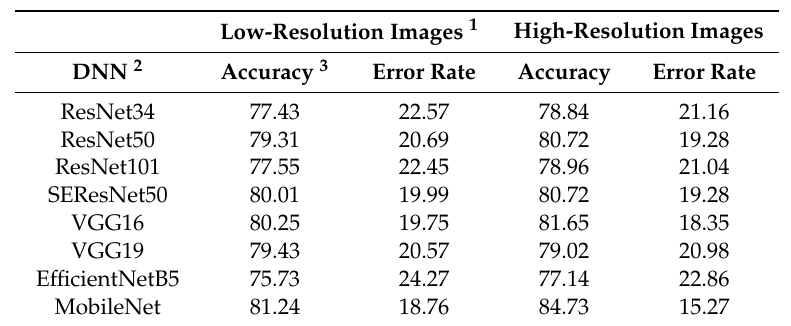
Table 3. Classification metrics of HAM10000 low- and high-resolution images with aggregated clinical data using eight di ff erent